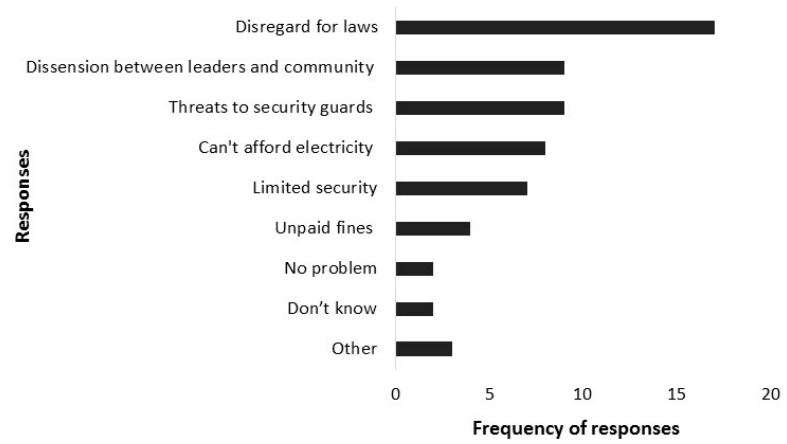
Figure 2. Frequency of firewood governance issues raised in focus groups ( n = 30) across all villages. Land 2018 , 7 , x FOR PEER REVIEW